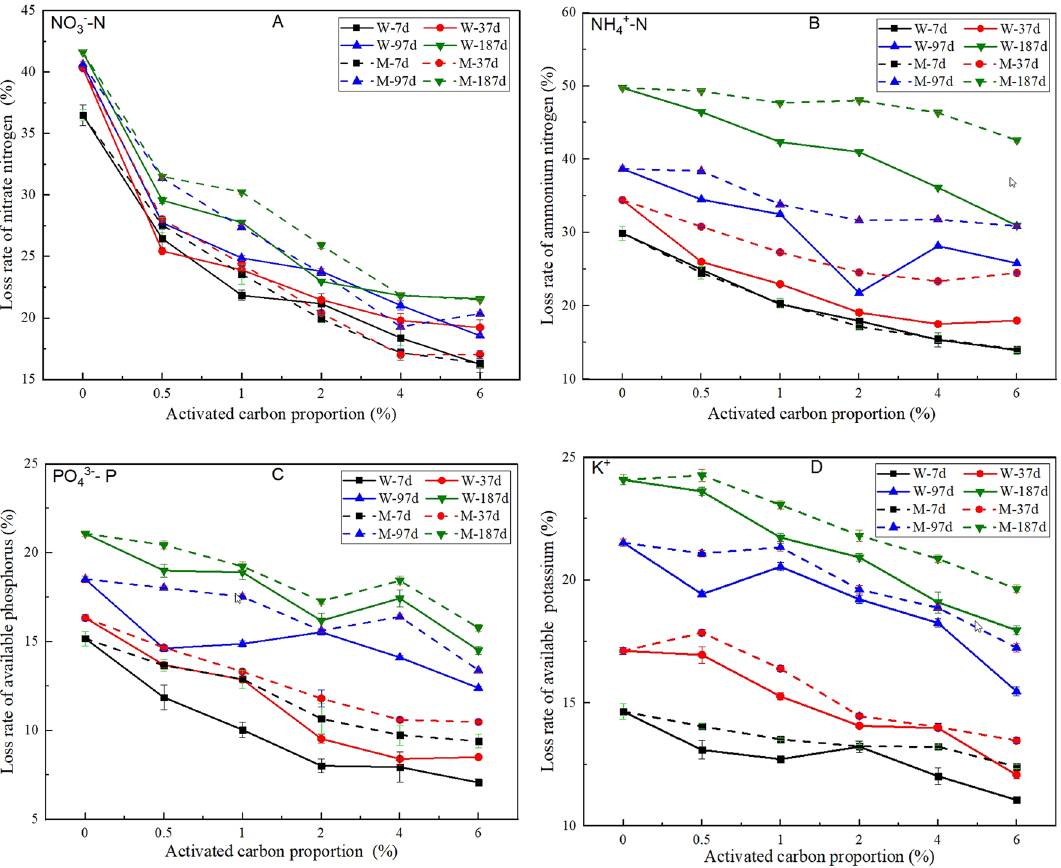
Figure 9. Effect of activated carbon on the loss rates of nitrate nitrogen ( A ), ammonium nitrogen ( B ), available phosphorus ( C ) and available potassium ( D ) of vegetation concrete.